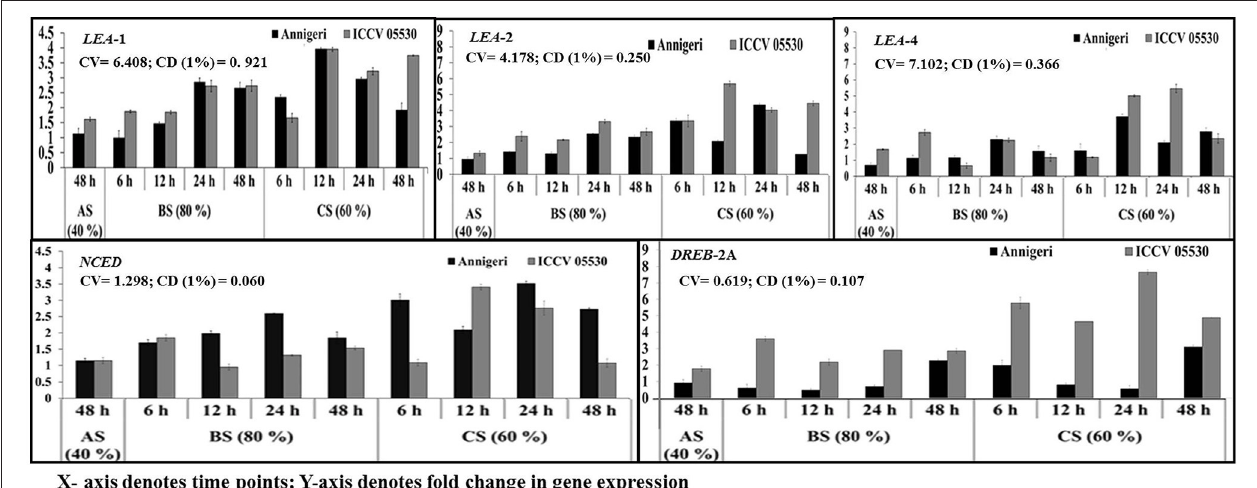
FIGURE 7 | RT-qPCR analysis of different moisture stress responsive genes differentially expressed in chickpea during interaction with S. rolfsii at limiting (40%), lower optimum (60%), and optimum (80%) soil moisture conditions. Time (in hours) and fold change in gene expression are shown on X and Y axis, respectively. Standard error of three biological replications was calculated and represented as error bar. AS, BS, and CS denote abiotic stress, biotic stress, and combined stress respectively. The statistical significance of gene expression in between the control and treated seedlings was calculated by factorial